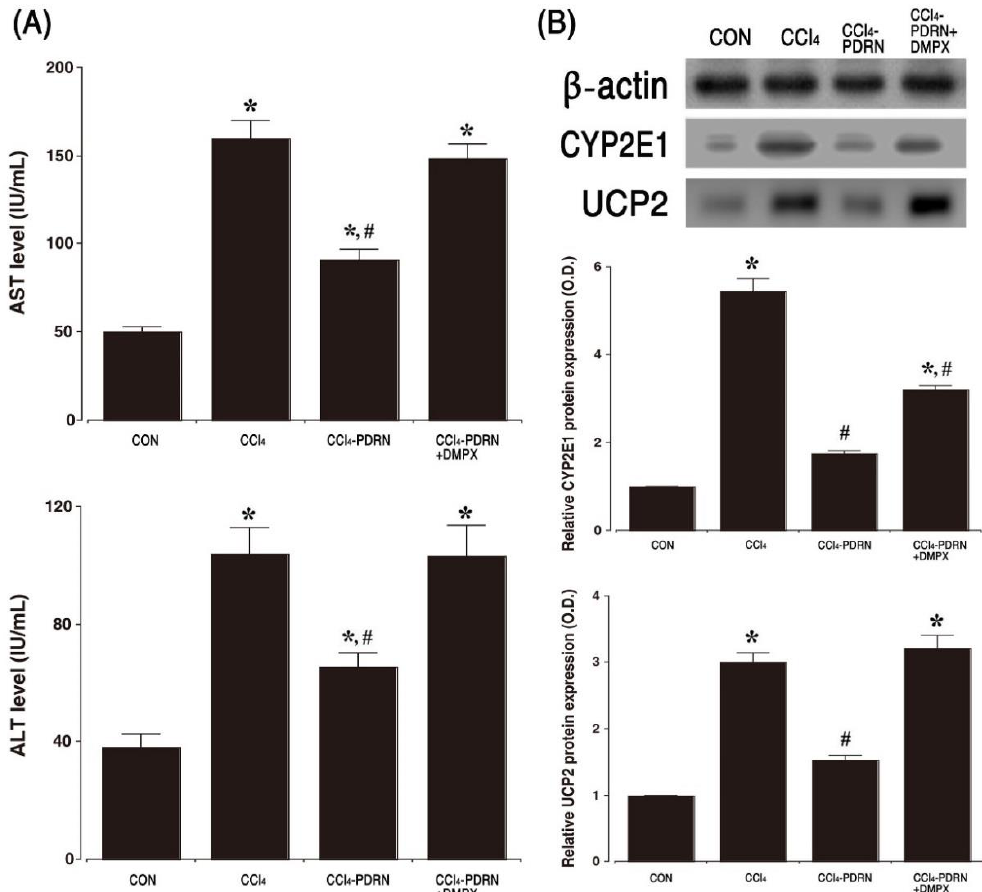
Figure 1. Level of aspartate aminotransferase (AST) and alanine aminotransferase (ALT), and expression of cytochrome P450 2E1 (CYP2E1) and uncoupling protein 2 (UCP2). ( A ) Concentration of AST and ALT in serum. ( B ) Representative expression of CYP2E1 and UCP2 in liver tissue. CON, control group; CCl 4 , CCl 4 -injection group; CCl 4 -PDRN, CCl 4 -injection and polydeoxyribonucleotide (PDRN)-treated group; CCl 4 -PDRN + DMPX, CCl 4 -injection and PDRN with 3,7-dimethyl-1-propargylxanthine (DMPX)-treated group. * indicates p < 0.05 when compared with the control group. # indicates p < 0.05 when compared with the CCl 4 -injection group.